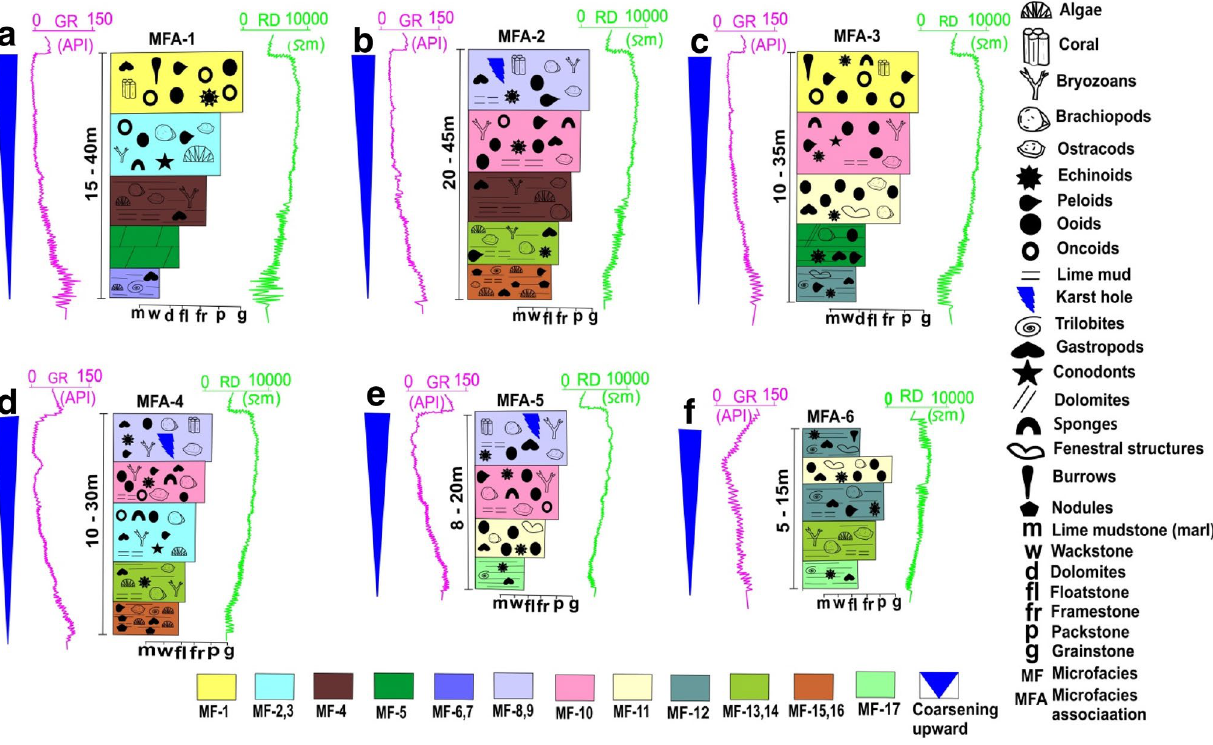
Fig. 8 Microfacies associations that developed in platform interior (restricted platform, intraplatform and open platform) and platform margin in the Lower Ordovician carbonate succession. These microfacies associations represent different facies transition trends and third-order sequences